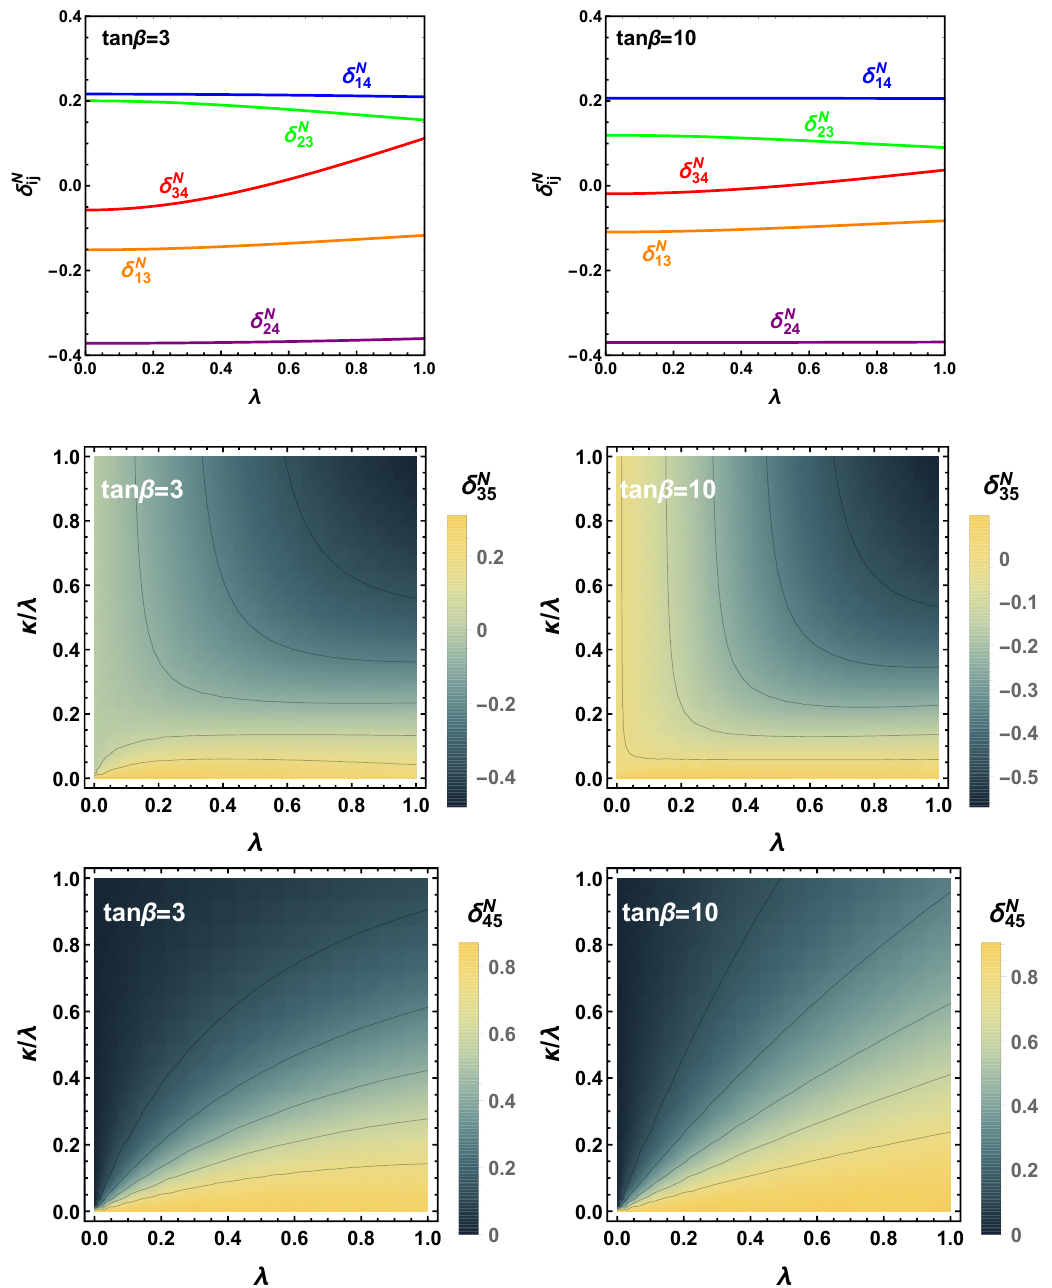
Figure 2 . Dependence of the MI parameters (cid:14) N (cid:21) and (cid:20) , with tan (cid:12) (cid:12)xed at 3 (left panel) and 10 (right panel),